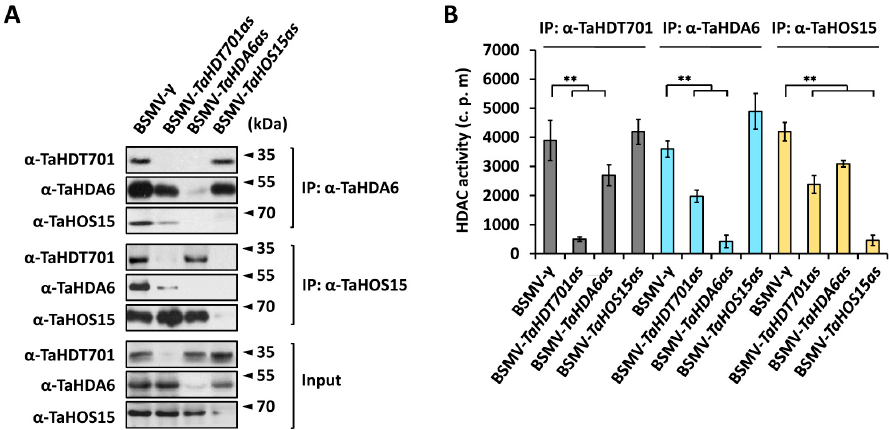
Figure 3. TaHDT701 associates with TaHDA6 and TaHOS15 in a histone deacetylase complex in bread wheat. ( A ) Nuclear co-immunoprecipitation (co-IP) interaction analysis among TaHDT701, TaHDA6, and TaHOS15. Nuclear protein was extracted from the indicated BSMV-VIGS wheat leaves and subjected to immunoprecipitation with the α -TaHDA6 and α -TaHOS15 antibodies. The co-immunoprecipitation of TaHDT701, TaHDA6, and TaHOS15 was probed with the antibodies α -TaHDT701, α -TaHDA6, and α -TaHOS15. ( B ) Immunoprecipitation analysis of endogenous histone deacetylase activity in different background. Nuclear extracts were prepared from the indicated BSMV-VIGS leaves and immunoprecipitated with antibodies α -TaHDT701, α -TaHDA6, and α -TaHOS15. The immunoprecipitated complexes were examined for histone deacetylase activity, which was given as radioactivity (c.p.m.) of [ 3 H]-acetate released from an acetylated histone H4 peptide. Data are means from three independent biological repeats. Significant differences were determined using Student’s t-test: ** p < 0.01.